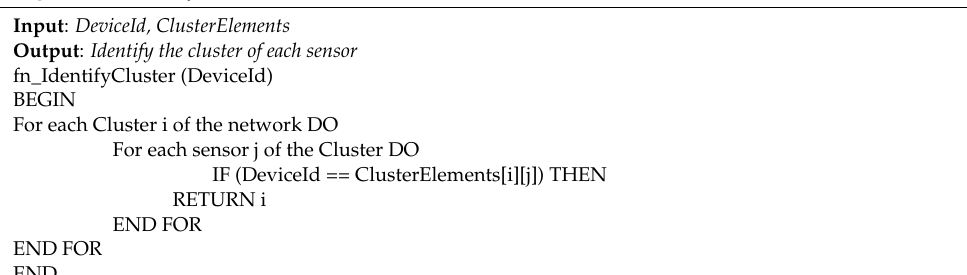
Algorithm 4 Identify the cluster of each sensor